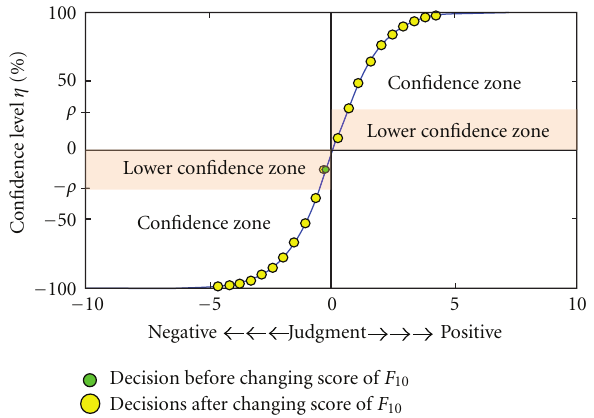
Figure 9: Fact finding of evaluator E 1 by varying the evaluation of factor F 10 over the interval [ − 10,10]. Before changing the score of the factor F 1 , the confidence of the decision of evaluator E 1 is − 14%. After changing the score of the factor F 10 , the confidence level of the decision of evaluator E 1 varies over a large range of [ − 98.26 %,